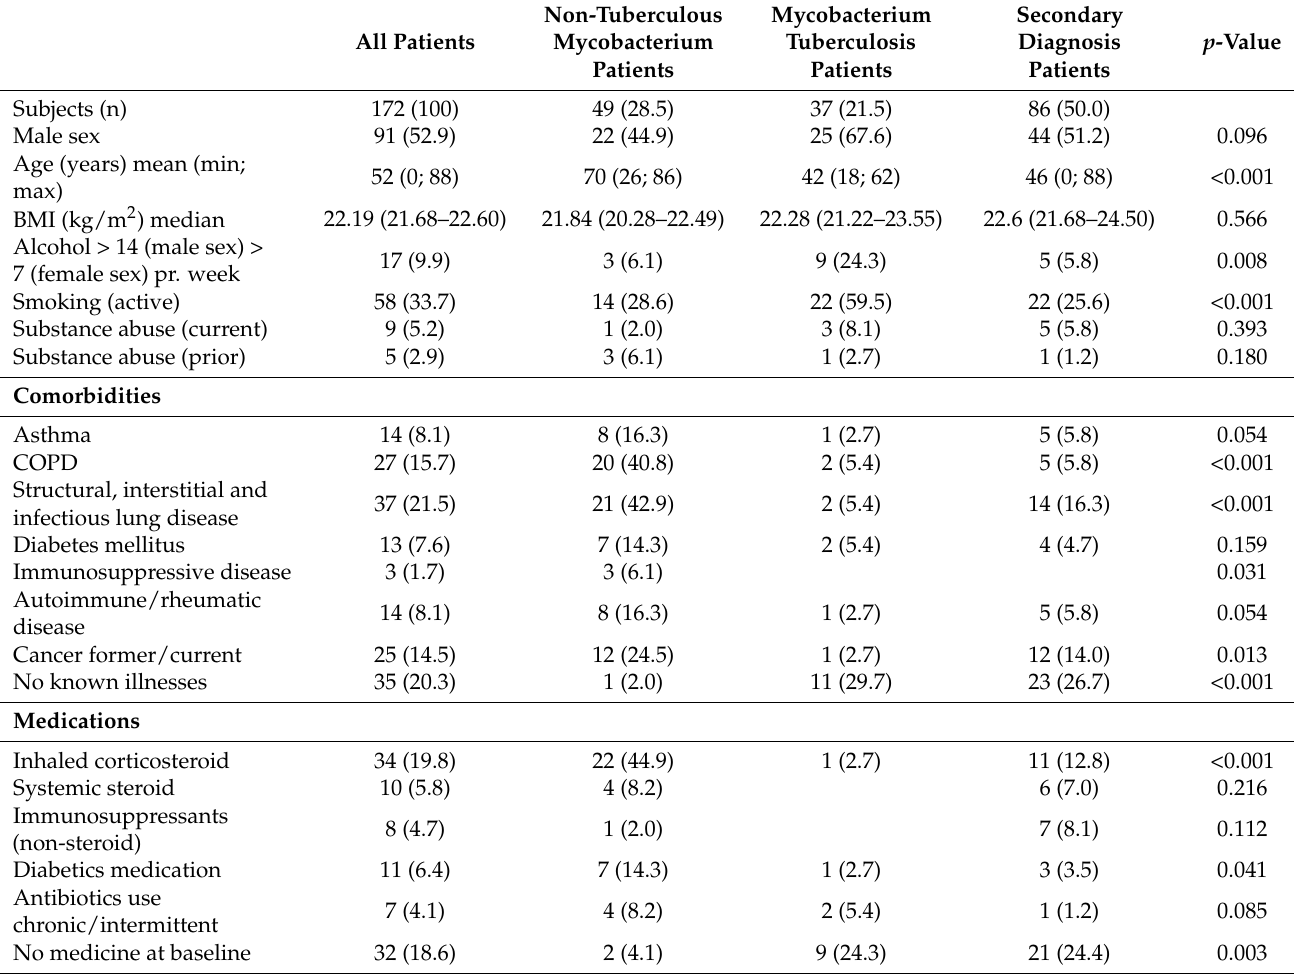
Table 1. Population